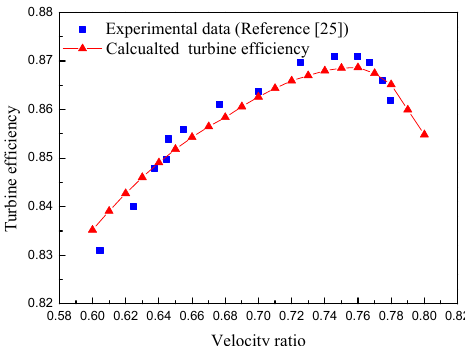
Figure 5. Validation of the turbine efficiency prediction model.